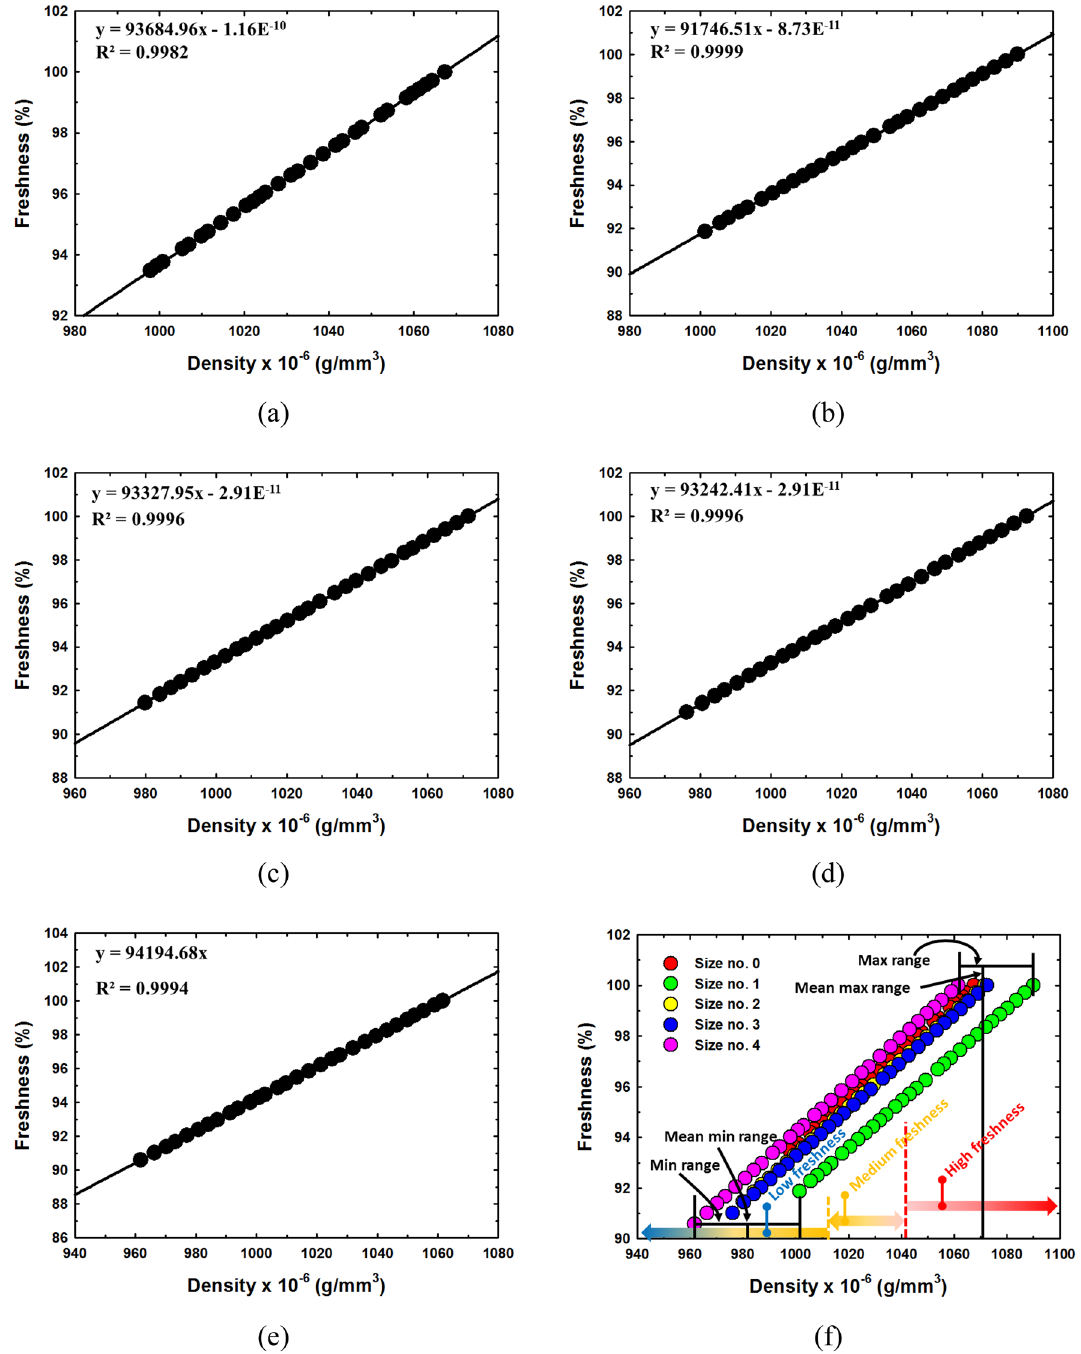
Figure 10. Freshness as function of density ( a ) size classification number 0, ( b ) size classification number 1, ( c ) size classification number 2 ( d ) size classification number 3, ( e ) size classification number 4 and ( f ) the range of